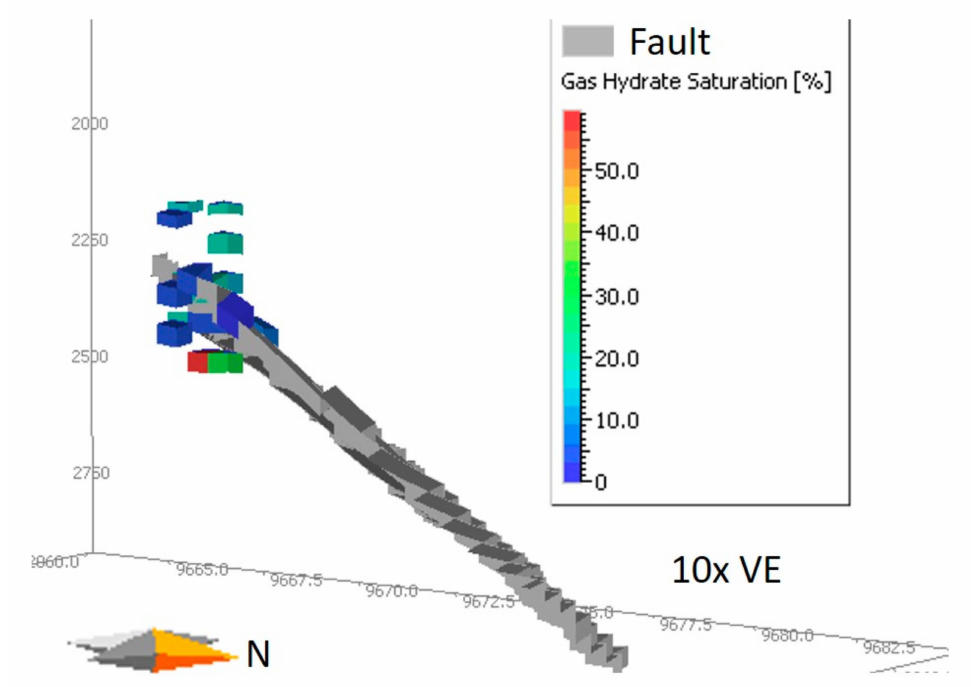
Figure 4. Three-dimensional view of model cells with greater than 1% gas hydrate saturation (blue, green, and red cells) and of the fault plane (grey cells). Scenario shown is for 0.1 wt. % TOC, 100 HI. Note 10 × vertical